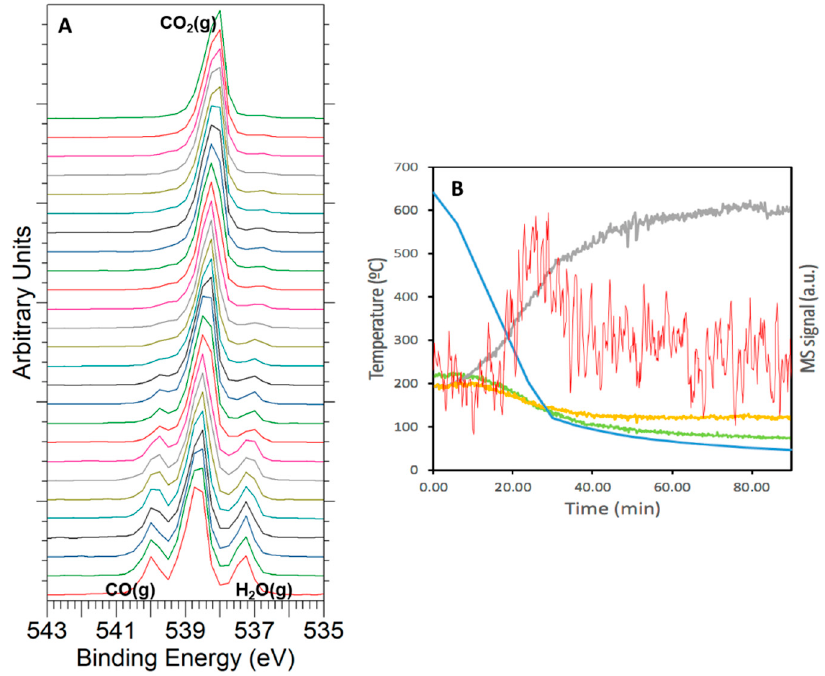
Figure 10. ( A ) Evolution of the O 1 s signal for the gas phase under reaction conditions when cooling from 640 ◦ C (bottom) to 80 ◦ C (top). ( B ) Mass spectrometry (MS) signal registered for CO 2 (gray, m / z = 44), CO (yellow, m / z = 28), and H 2 O (green, m / z = 18), and CH 4 (red, m / z = 15) during cooling (in blue, temperature